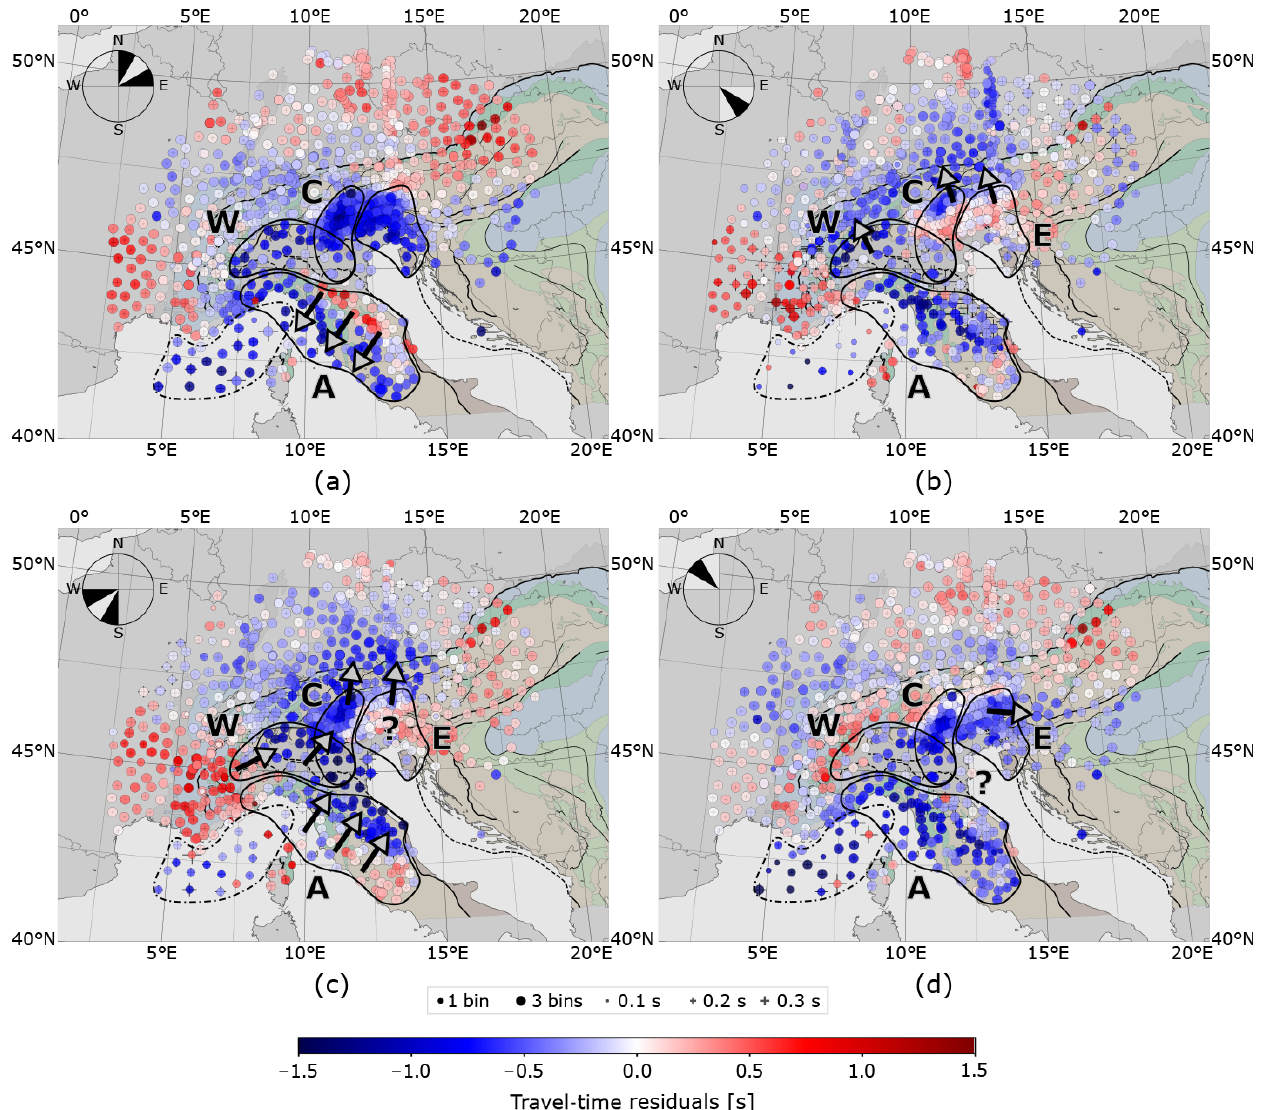
Figure 11. Travel-time residuals stacked for 90 ◦ quadrants NE, SE, SW, NW. For each quadrant the travel-time average of three possible 30 ◦ bins is shown. Circles of stations with incomplete coverage appear smaller; e.g. in (b) several directions are missing for OBS from SE direction, which has the lowest event coverage. Dashed lines show outlines of the same negative residual anomalies as in Fig. 10. Arrows indicate a lateral movement of anomaly imprints caused by an illumination of waves of different